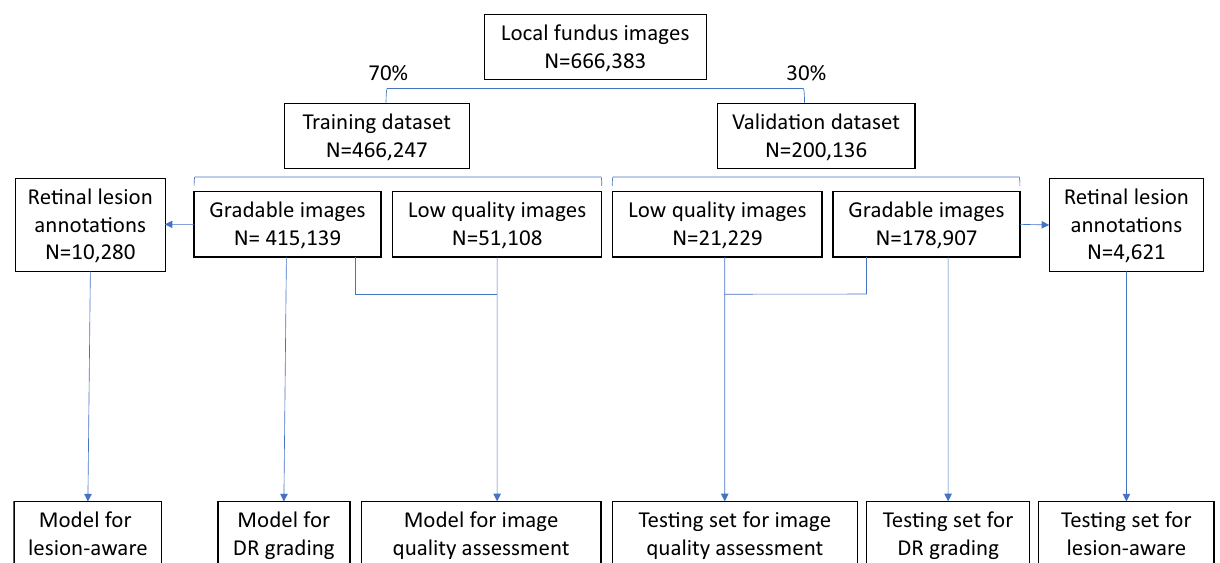
Fig. 1 Data split in the local dataset (SIM cohort) for the training and local validation of the three sub-networks of the DeepDR system. The local dataset was randomly divided into training or validation datasets. All 466,247 images in the training dataset were used for training the image quality assessment sub-network. The lesion detection sub-network was trained using 10,280 gradable images with retinal lesion annotations. Then, 415,139 gradable images in the training set were used for the training of the DR grading sub-network. All 200,136 images in the local validation dataset were used to test the image quality sub-network, and 178,907 gradable images were used to test the DR grading sub-network. Finally, 4621 gradable images labeled with retinal lesions were used to test the lesion detection sub-network. DR, diabetic